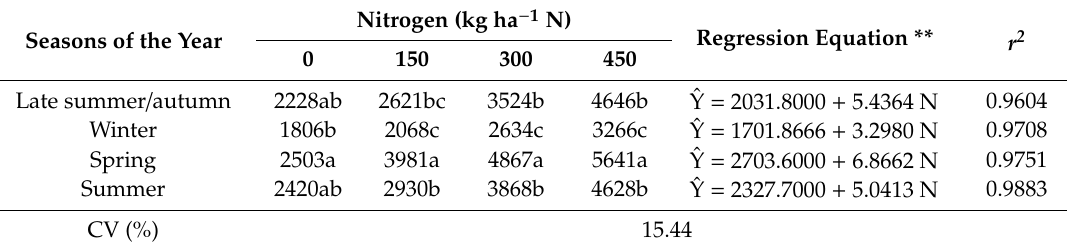
Table 4. Averages for pre-grazing forage mass (kg DM ha − 1 ) of Brachiaria brizantha cv. Piat ã under rotational stocking and nitrogen fertilization throughout seasons of the year.